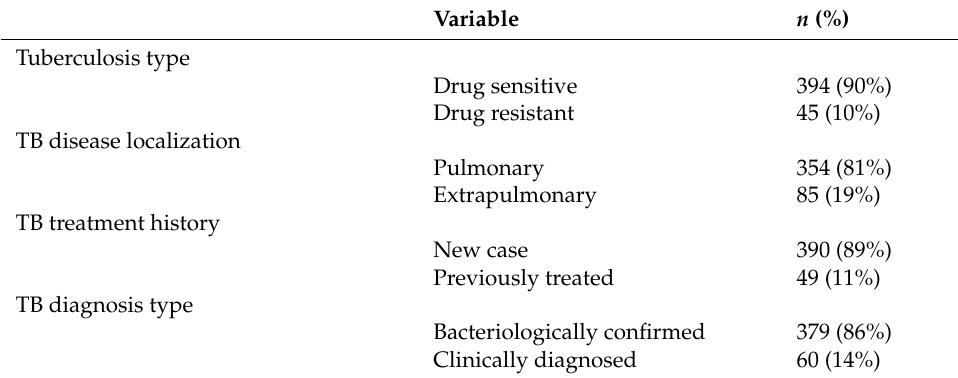
Table 2. Clinical characteristics of the study sample ( n =